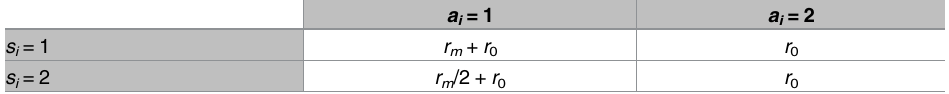
Table 2. Reward when field i is in state s i at time t and action a i is